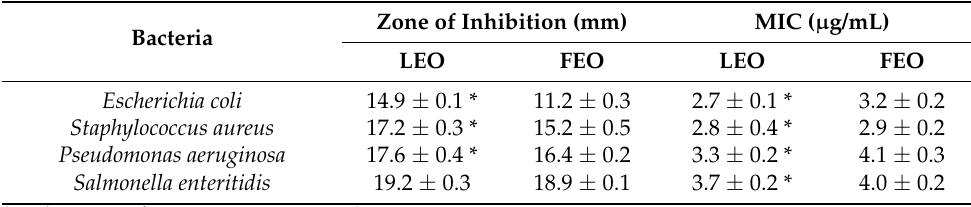
Table 2. Antibacterial activity of C. verum leaf (LEO) and flower (FEO) essential oils in terms of zone of inhibition and the Minimum inhibitory concentrations ( µ